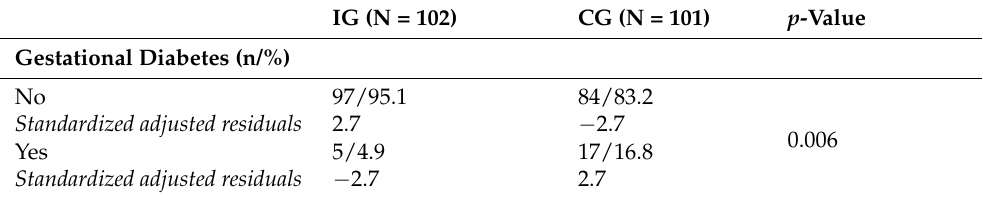
Table 2. Cases of gestational diabetes in intervention and control